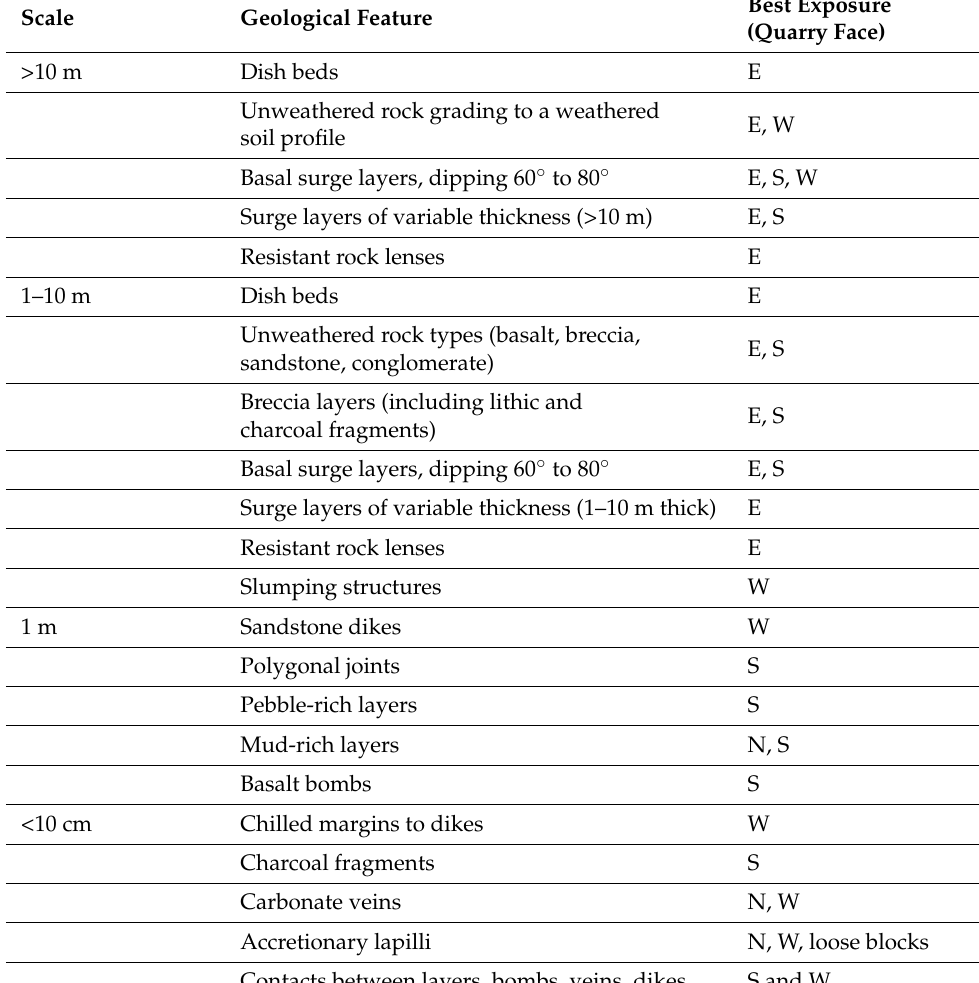
Table 2. Geological features of geoheritage significance recorded at Hornsby Quarry on site visits.